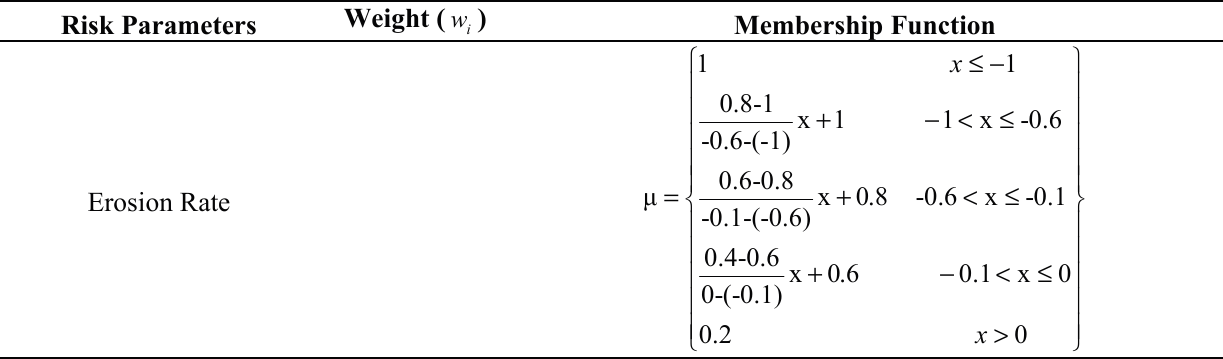
Figure 9. Fuzzy representation of coastal erosion risk zones on the study